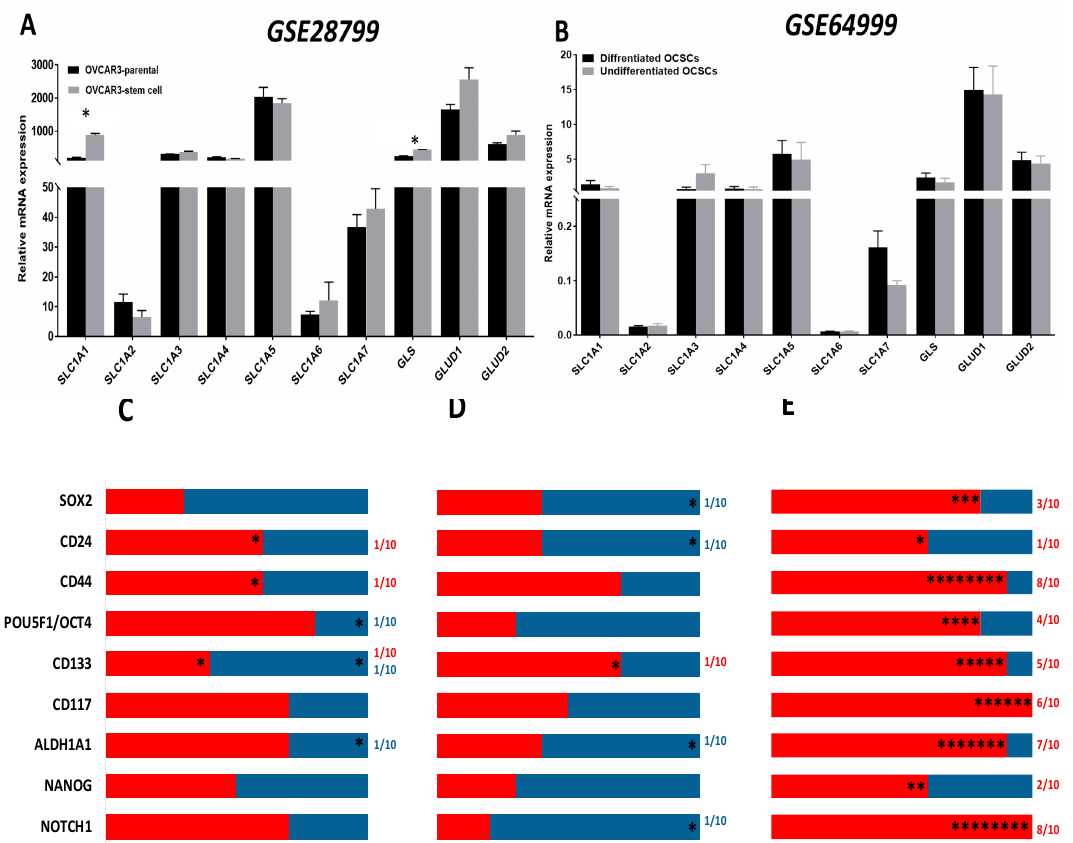
Figure 8. Expression of transporters and enzymes of glutamine/glutamate metabolism in OCSC models. ( A , B ) Bars represent mean ± SEM of the relative mRNA expression of the indicated transporters and glutamine/glutamate metabolism enzymes in OVCAR3 stem-cells vs. their parental cells in GSE28799 and undifferentiated vs. differentiated OCSCs in GSE64999. Significance was determined using the multiple t -test and Holm–Sidak method with each row analyzed individually with p < 0.05, without assuming a consistent SD. ( C – E ) Bar graphs represent the prevalence of positive ( red ) and negative ( blue ) correlations of the indicated OCSC markers and glutamine/glutamate metabolism enzymes in Supplement Tables S9–10 and Table 5. * indicate the number of significant correlations either positive or negative.